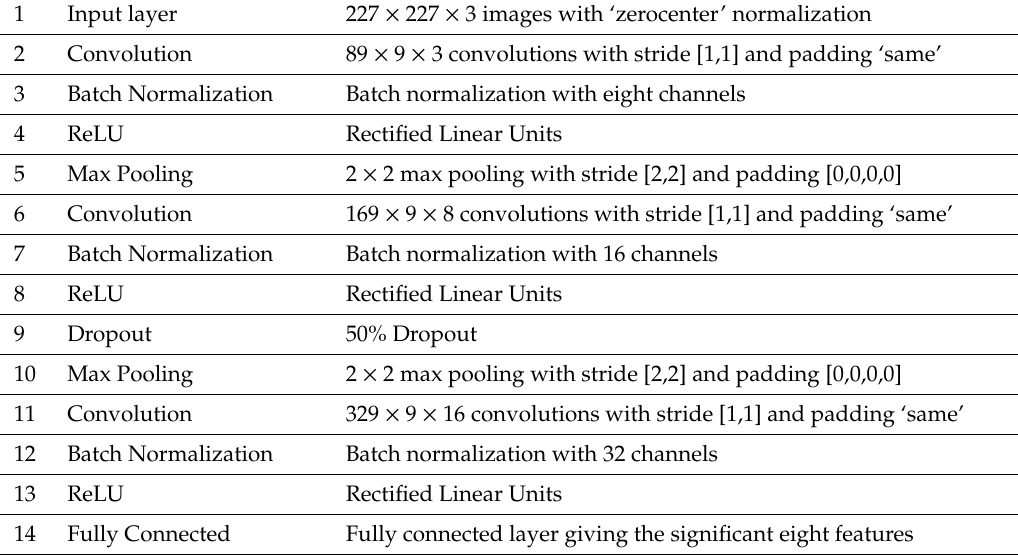
Figure 8. Architecture of an ANN model.